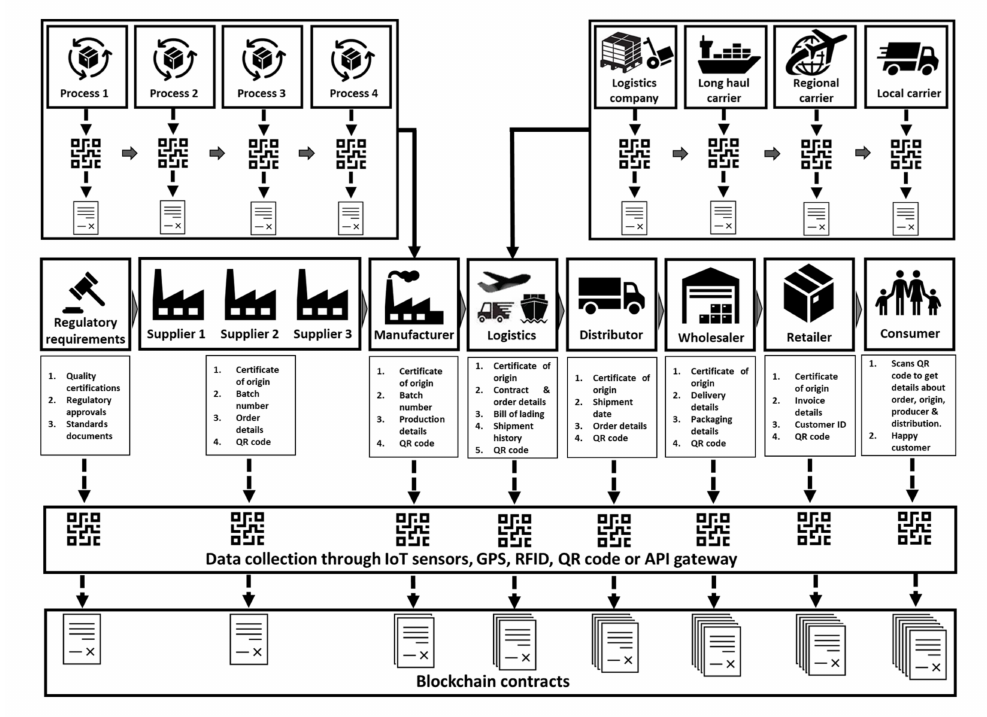
Figure 5. Blockchain technology in a manufacturing supply chain and